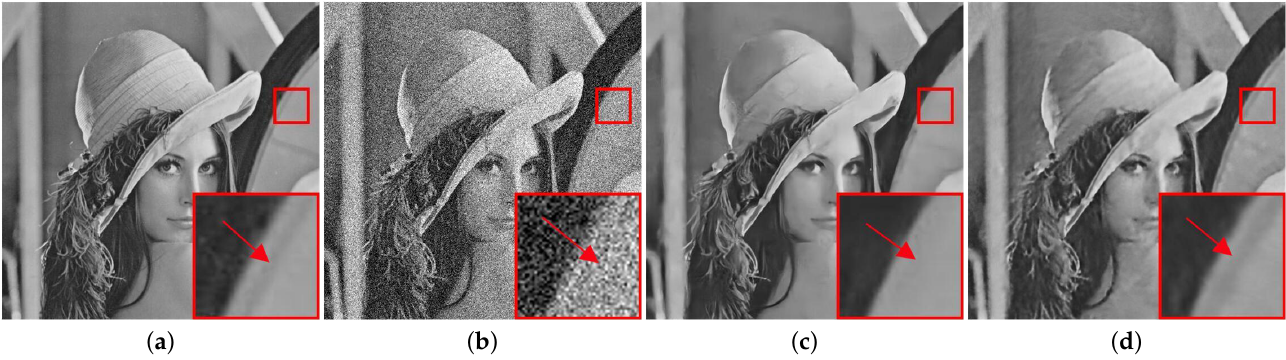
Figure 1. Denoising results on Lena with noise level σ = 40: ( a ) Original; ( b ) Noisy, ( c ) DNCNN/PSNR = 30.47 dB; ( d ) DIP/PSNR = 29.43